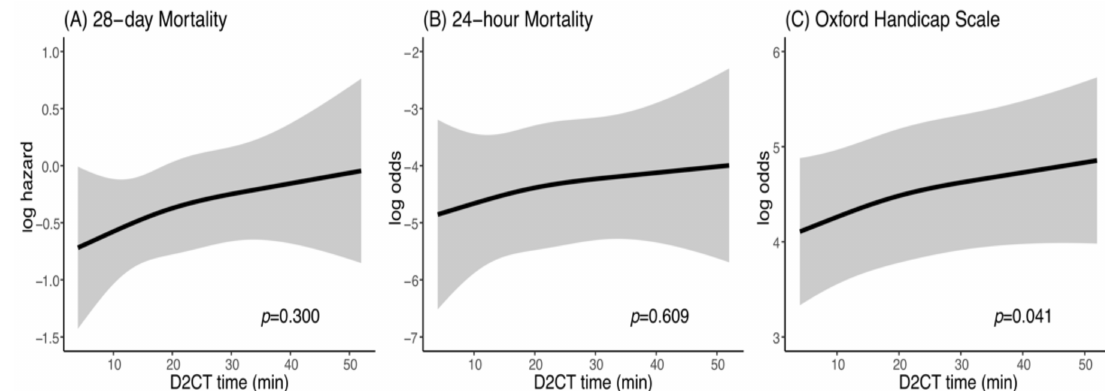
Figure 2. Effect of earlier D2CT on ( A ) 28-day mortality, ( B ) 24-h mortality and ( C ) Oxford Handicap Scale. PH, proportional hazard; CT, computed tomography; D2CT,